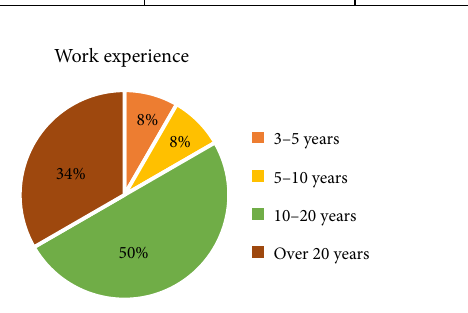
Figure 4. Interviewees by age Figure 5. Interviewees by work experience